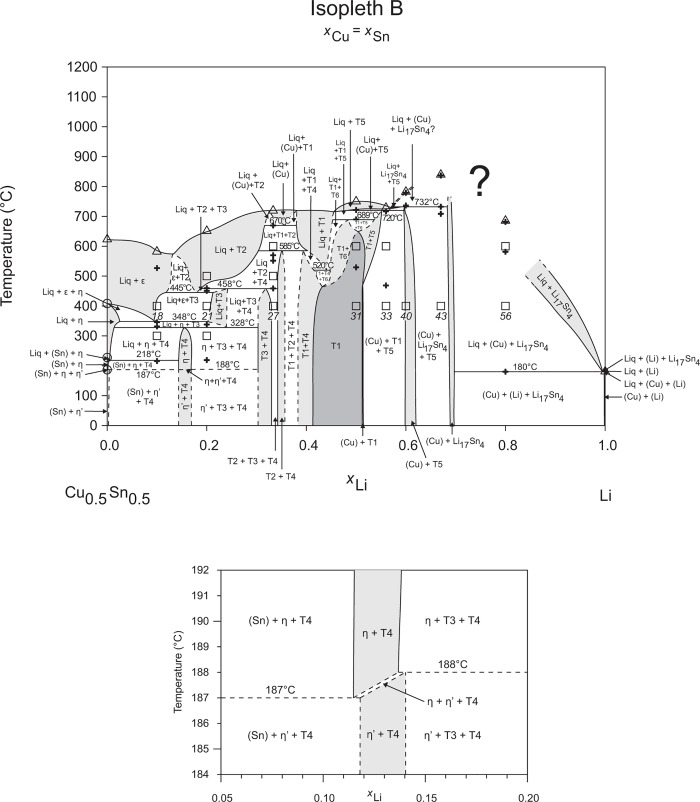
Isopleth B including section from xLi = 0.05–0.20 / T = 184–192°C.